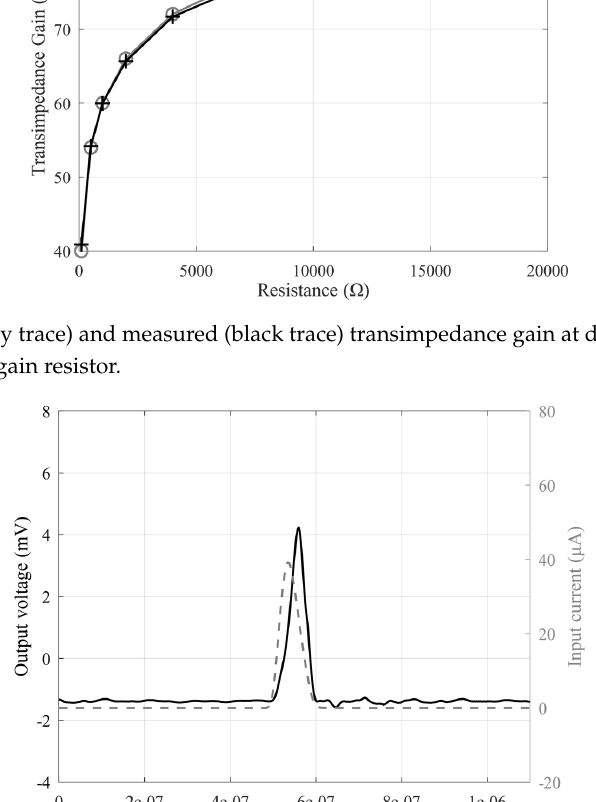
Figure 13. Ideal (grey trace) and measured (black trace) transimpedance gain at different values of the external X terminal gain resistor.